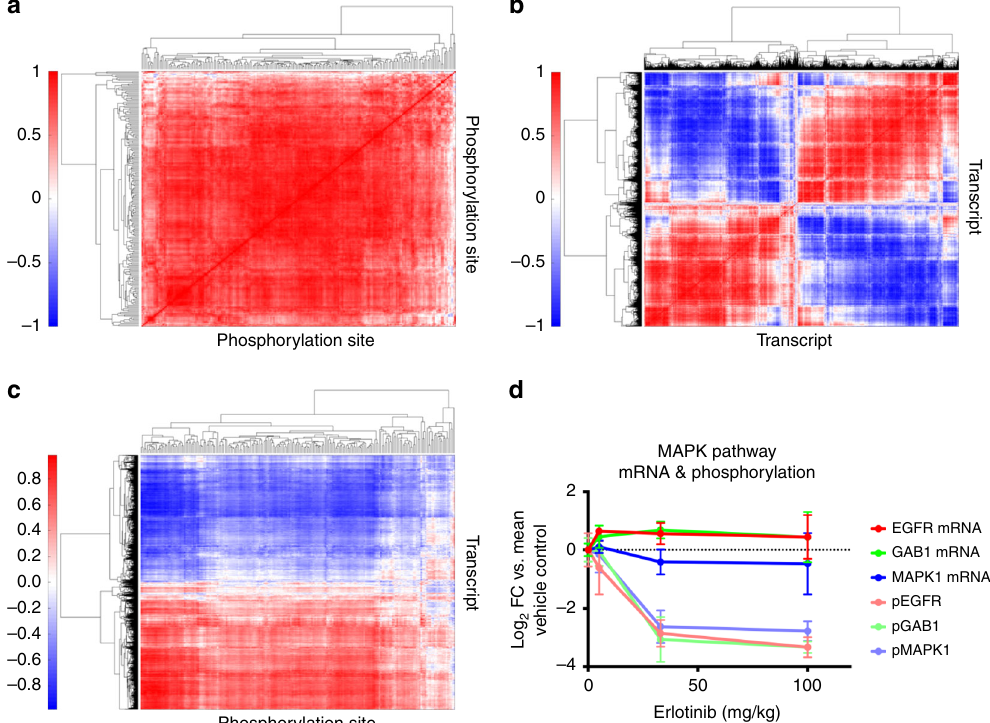
Fig. 7 Integrative analysis of phosphoproteomic and mRNASeq data. a Hierarchical clustering of correlation matrix for phosphoproteomic data reveals that most sites are correlated. Sub-clusters highlight known interactions as potentially novel signaling network. b Clustering of mRNA correlation matrix highlights the bi-modal response to Erlotinib, with most transcripts either decreasing or increasing on Erlotinib treatment and thus either positively or negatively correlated with other transcripts. c Clustering of phosphoproteomic and mRNASeq correlation matrix. Phosphorylation sites tend to decrease on Erlotinib treatement and are therefore positively correlated with approximately half of the transcripts and negatively correlated with the other half of the transcripts. Sub-clusters of phosphorylation sites indicate well-established signaling networks. d Line graphs showing analysis of correlation between phosphorylation sites and their transcripts indicating that activation/inhibition of the kinase may be regulating the site. Error bars represent the standard